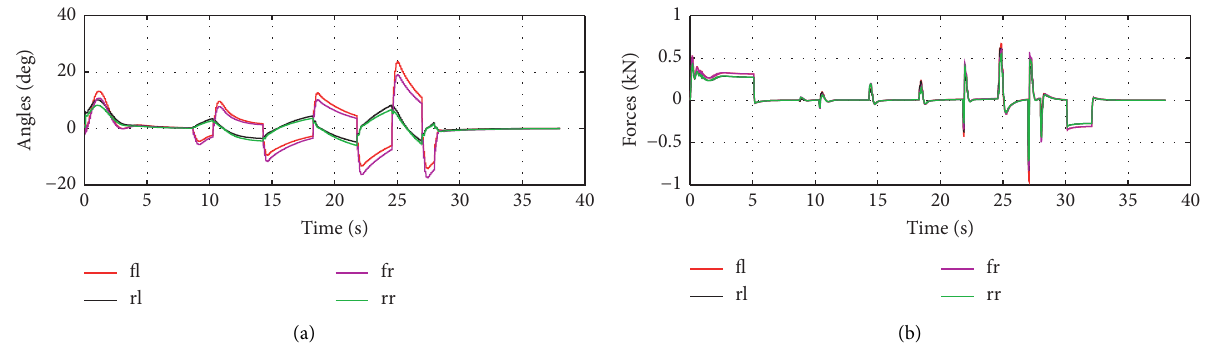
Figure 6: Time histories for steering angles of wheels and longitudinal forces of tires during the vehicle path-following control. (a) Wheel steering angle. (b) Longitudinal force of tire.